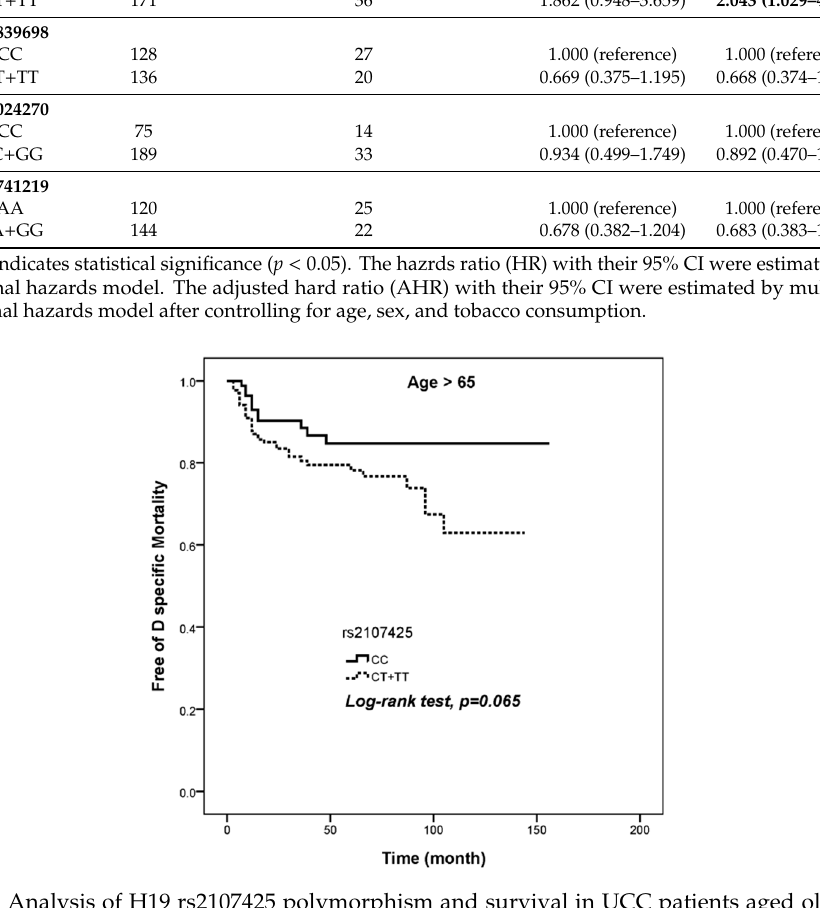
Figure 1. Analysis of H19 rs2107425 polymorphism and survival in UCC patients aged older than 65 years. Disease specific mortality among the two phenotypes of polymorphisms at H19 rs2107425 in patients aged older than 65 years.